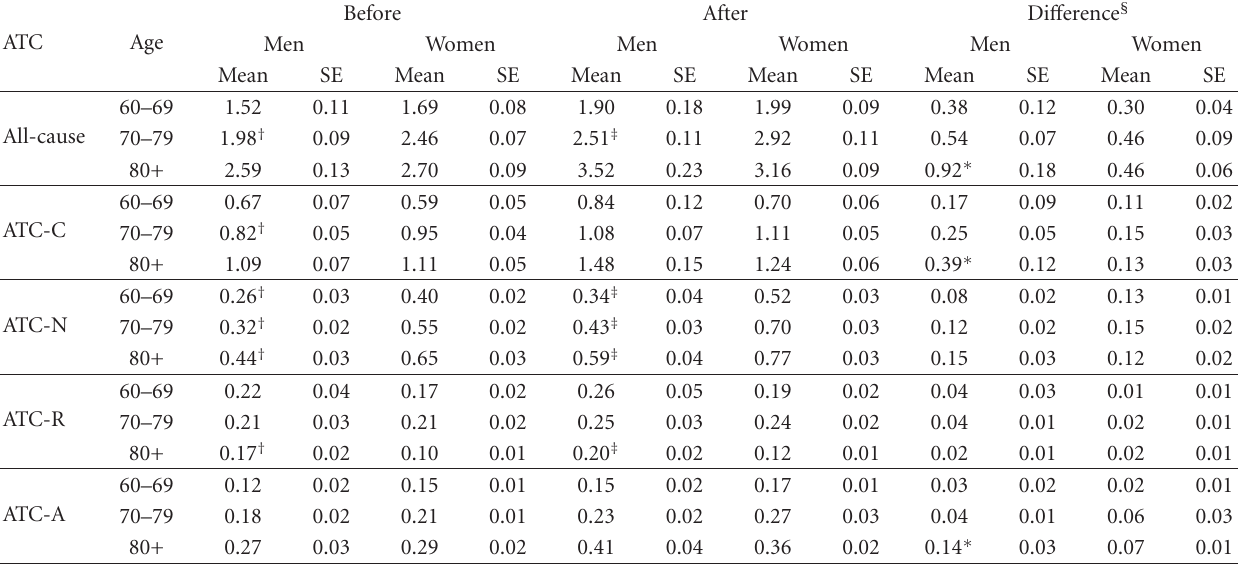
Table 2: Average daily defined dose of all-cause and system-specific medications dispensed within 1 year before and 1 year after widowhood. ATC